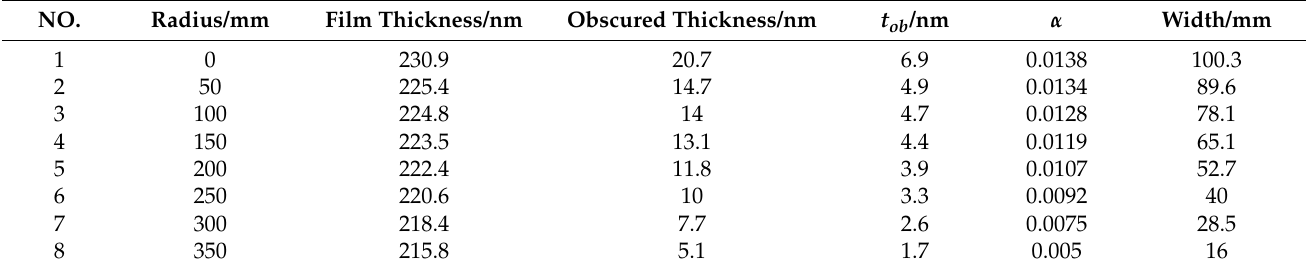
Figure 14. 3D map of the film thickness distribution on the surface of the reflective mirror. As shown in Figure 14, the film thickness at the edge of the reflective mirror is 215.8 nm ( ρ = 350 mm) and the width of the shadow mask at the edge is 16 mm. According to Equation (13), the film thickness obscured by the shadow mask is 5.1 nm and the t ob = 5.1/3 = 1.7 nm, with Equation (14) yielding α as 0.005. After being obscured, the thickness of the film at the edge of the reflective mirror is 210.7 nm. This means that the film thickness at other obscured radius locations should also be 210.7 nm. Table 1 shows the film thickness distribution at different radii of the reflective mirror, as well as the associated obscured thicknesses and widths of the shadow mask. Table 1. Film thickness distribution and the width of the shadow mask at different radius positions.